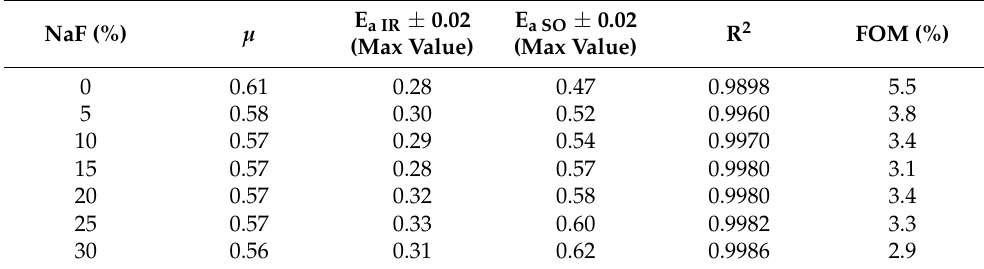
Table 1. Average results for samples irradiated at different irradiation dose. µ : peak shape factor, E a : activation energy, IR: initial rise method, SO: second order. FOM: figure of